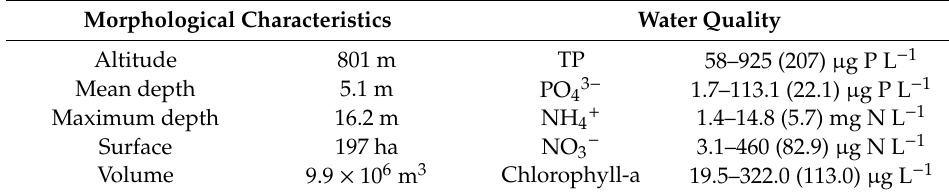
Figure 1. Lake Pampulha and its catchment location and tributaries: (1) Olhos d’água; (2) AABB; (3) Braúnas; (4) Água Funda; (5) Sarandi; (6) Ressaca; (7) Tijuco; (8) Mergulhão. Table 1. Lake Pampulha morphological characteristics [33] and water quality from December 2011 to May 2013 (minimum value - maximum value (average